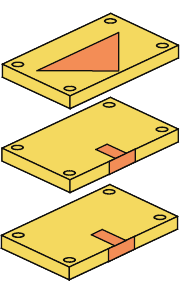
Figure 12: Metallized foam blocks before